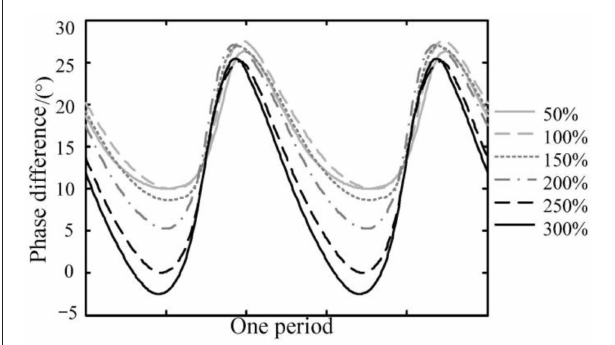
FIGURE 4 | Phase difference comparison in one period. FIGURE 6 | Backbone curve.